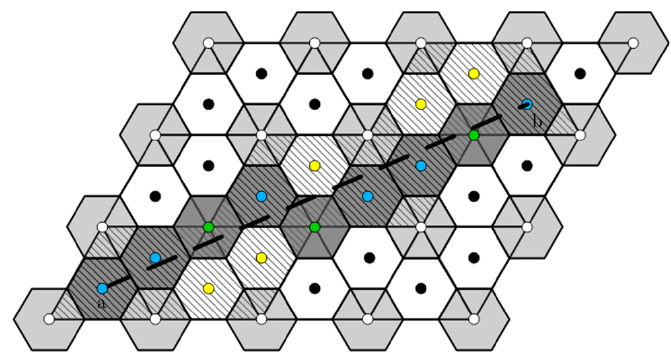
Figure 5. Corresponding relationship between two discrete line models.